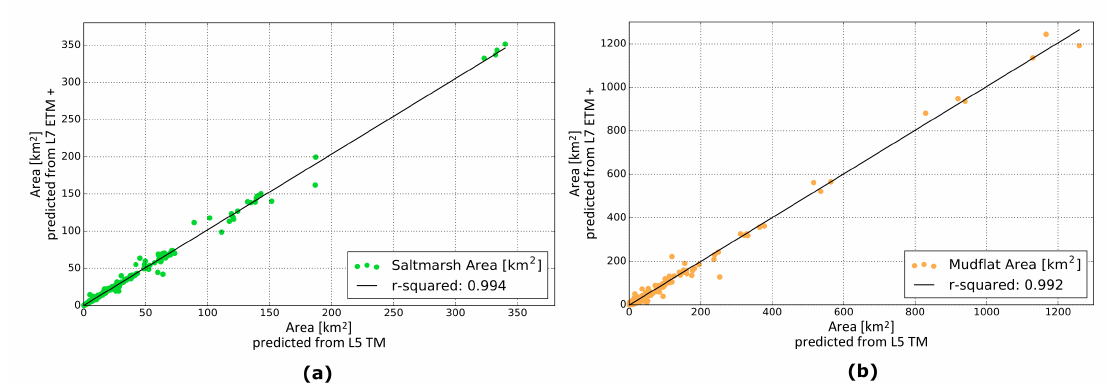
Figure 5. Correlation between ( a ) predicted saltmarsh area (slope: 1.017) and ( b ) predicted mudflat area (slope: 1.005) between 2000 and 2011 detected by unsupervised saltmarsh classification from Landsat 5 TM ( x -axis) and Landsat 7 ETM+ ( y -axis)